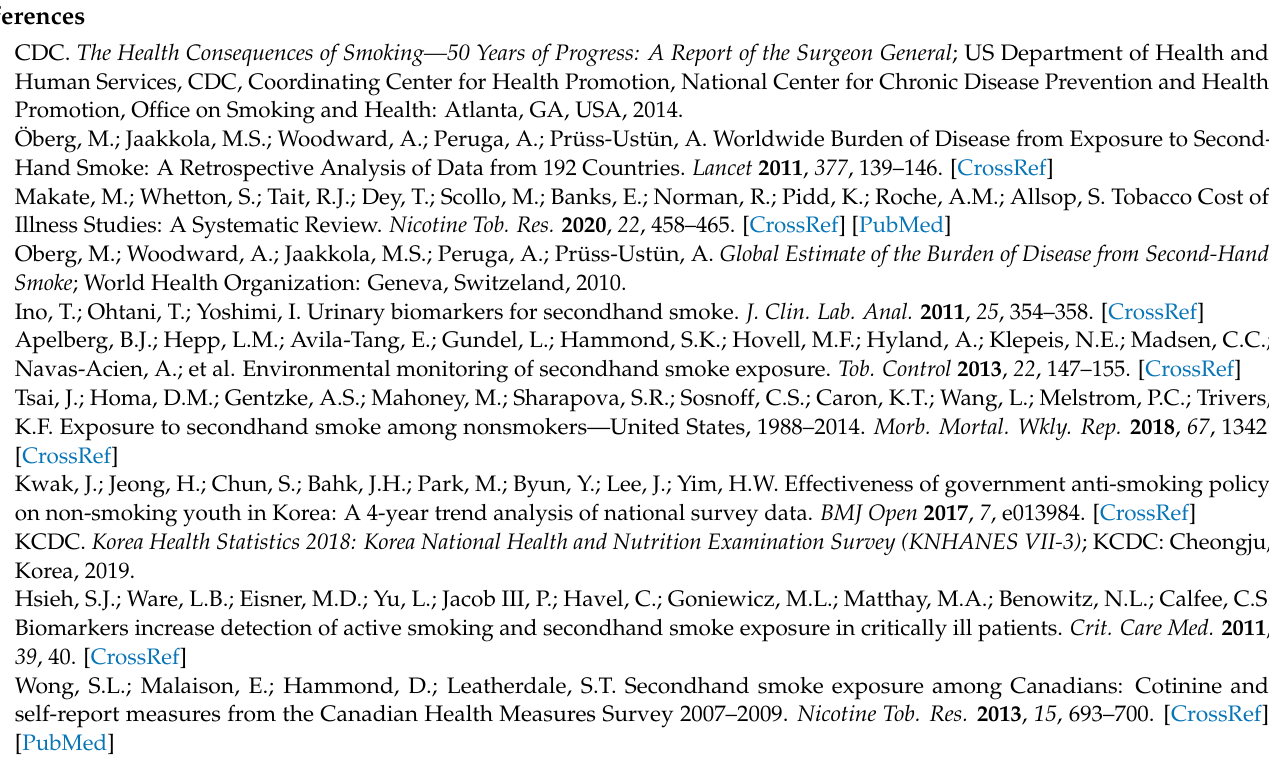
KCDC. Korea Health Statistics 2018: Korea National Health and Nutrition Examination Survey (KNHANES VII-3) ; KCDC: Cheongju, Korea, 2019.